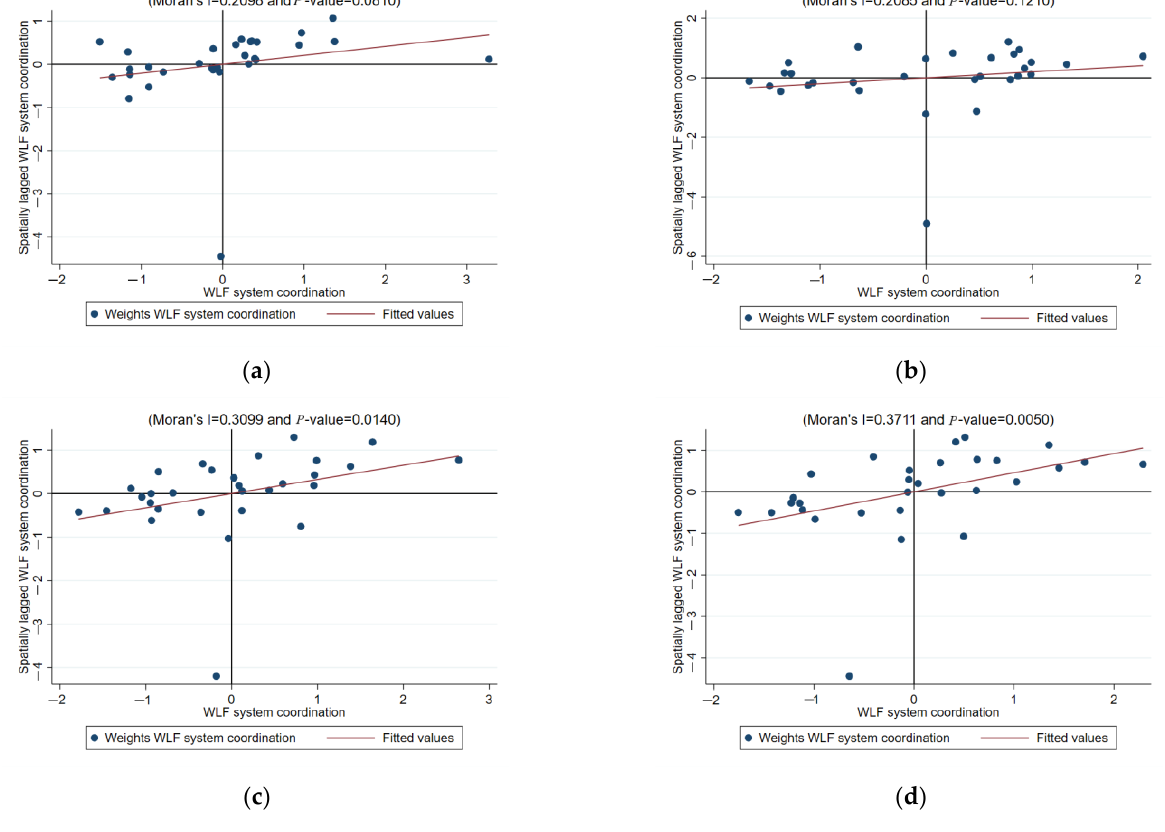
Figure 5. Moran scatter plots of global WLF nexus for different years. ( a ) 2003 WLF nexus; ( b ) 2008 WLF nexus; ( c ) 2013 WLF nexus; ( d ) 2018 WLF